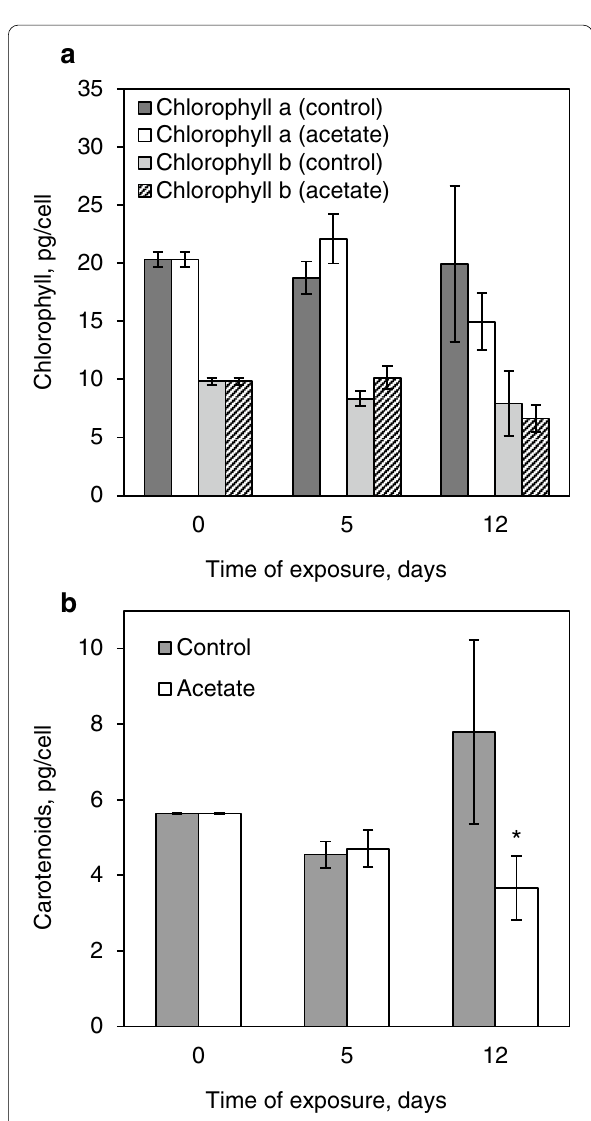
Fig. 8 Content of photosynthetic pigments in H. pluvialis cells after 5 and 12 days of cultivation under stress